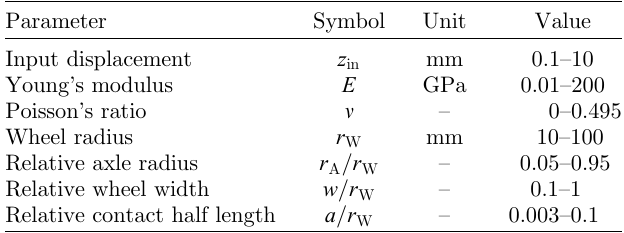
Table 1. Range of values used for each parameter.